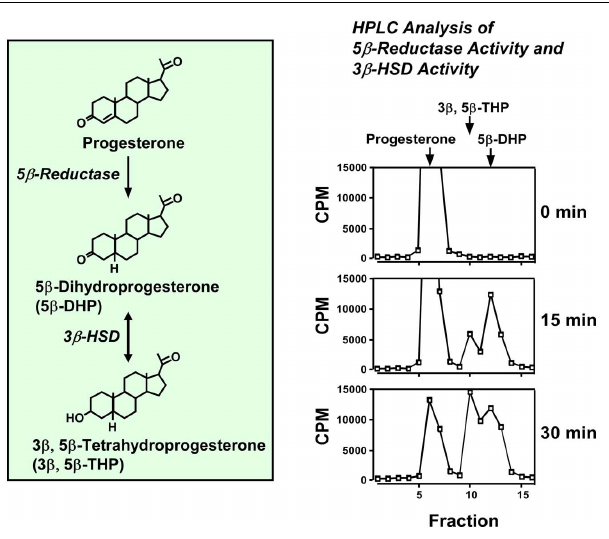
FIGURE 4 | Conversion of progesterone to 5 β -DHP and 3 β , 5 β -THP in the quail brain. HPLC analysis of neurosteroids extracted from quail brain homogenates after different incubation times with 3 H-progesterone using a reversed-phase column.The column was eluted with an isocratic elution of 70% acetonitrile.The ordinate indicates the radioactivity measured in each HPLC fraction.The arrows indicate the elution positions of progesterone, 5 β -DHP and 3 β , 5 β -THP. See Ukena et al. (2001) for